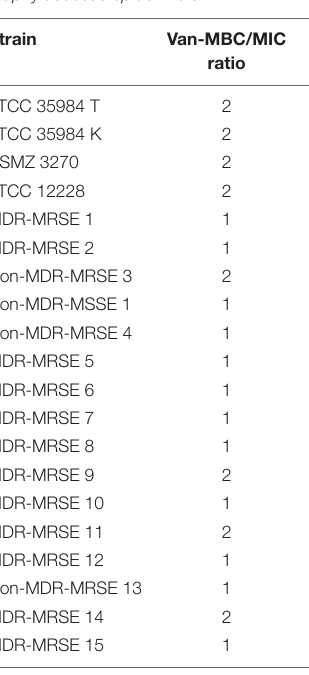
Rif-MBC/MIC Mel-MBC/MIC ratio ratio ratio